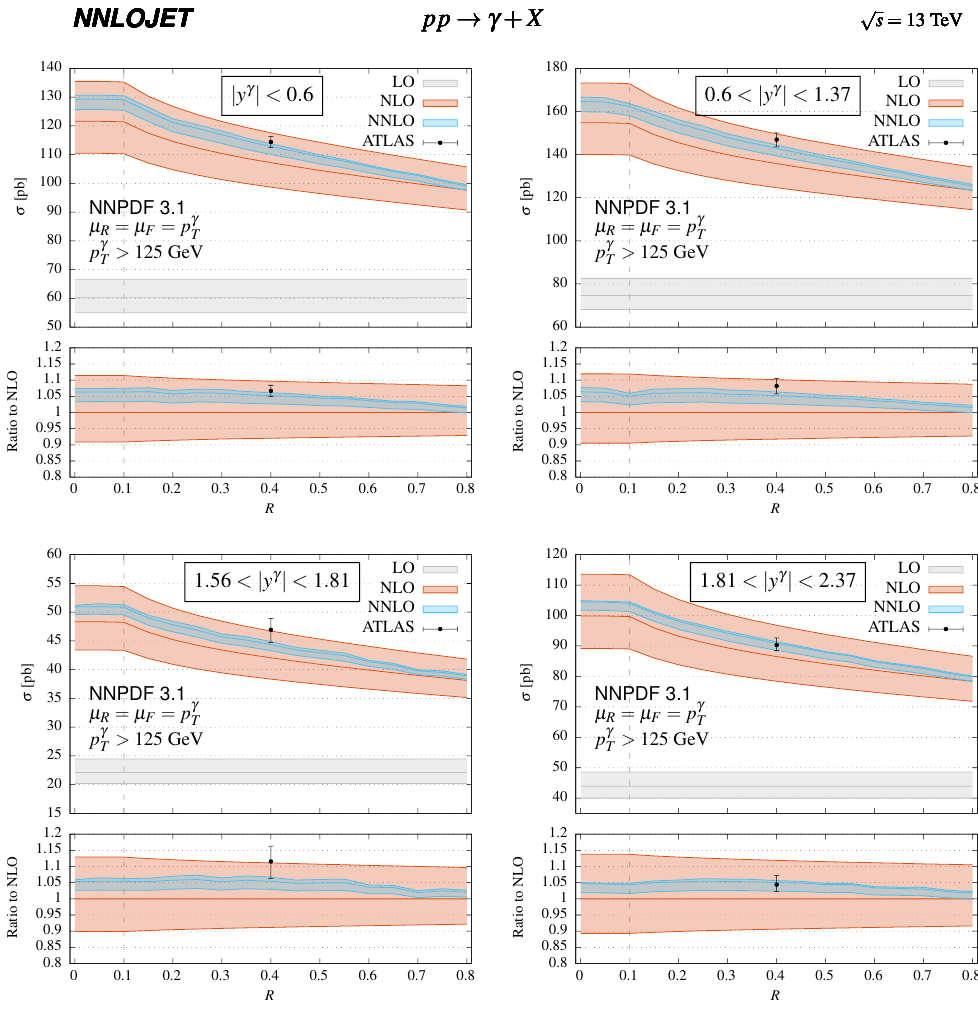
Figure 8 . Dependence of the total cross section for inclusive photon production at 13 TeV at LO, NLO and NNLO on the cone size R of the outer (cid:12)xed cone used in the hybrid isolation procedure, for di(cid:11)erent regions of the photon rapidity. All other isolation parameters are (cid:12)xed: R d = 0 : 1, " d = 0 : 1, n = 2, E thres = 4 : 8 GeV, " = 0 : 0042. The dashed line marks the cone size R d of the T dynamical cone. The ATLAS measurement [10] is performed only for a (cid:12)xed cone with size R = 0 :